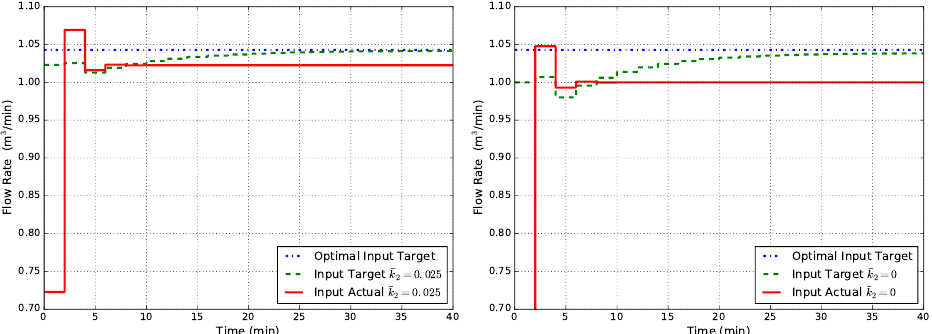
Figure 6. Closed-loop flow rate Q obtained with EMPC1-MT (state disturbance model, modified target problem) for two cases of uncertainty in k 2 : ¯ k 2 = 0.025 ( left ) and ¯ k 2 = 0 ( right ).